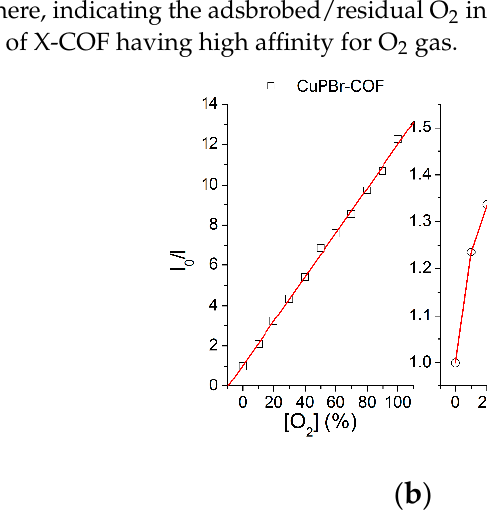
sensitivity, linear calibration curve, short response time, along with visual color change during sensing procedure.